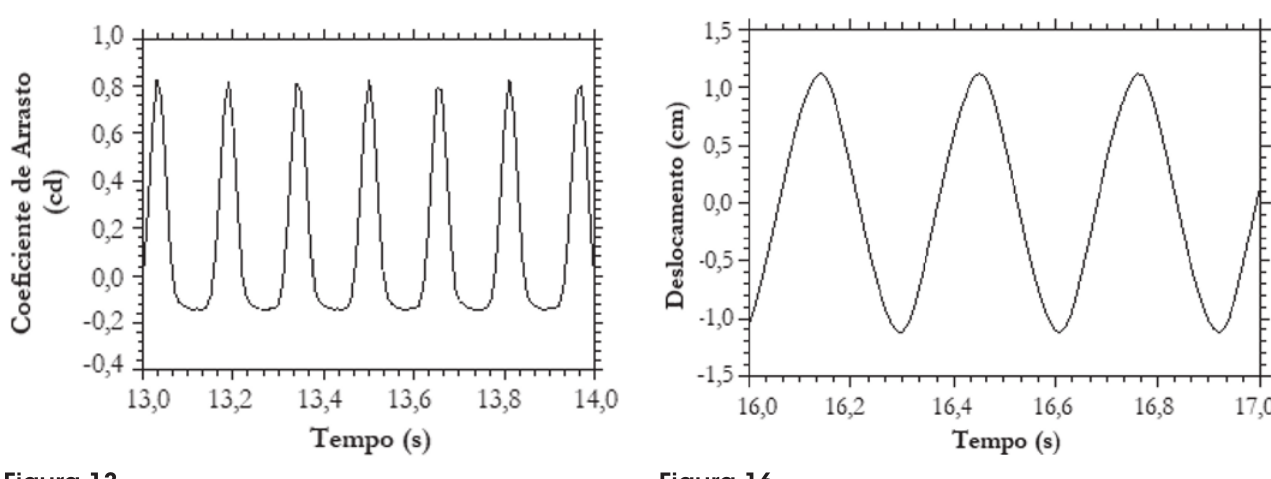
Deslocamento do vértice da direita da viga ao longo do tempo